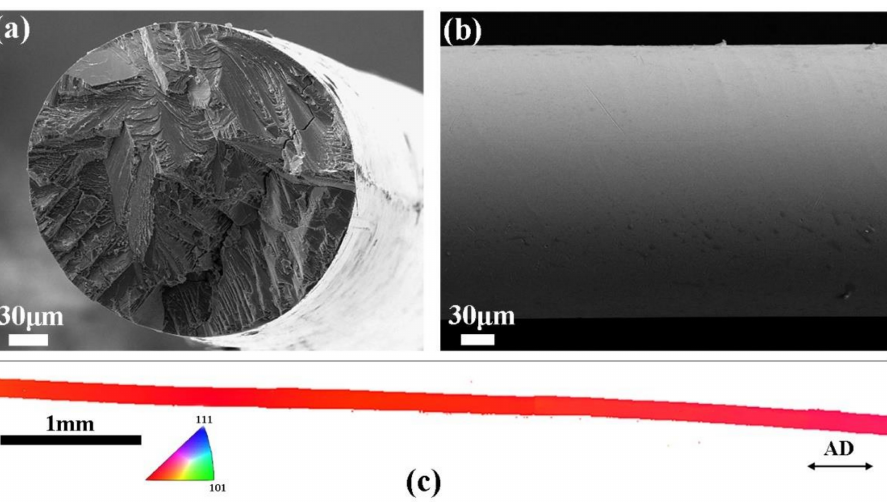
Figure 1. Microstructure of the Ni 50 Mn 34 Fe 3 In 13 microwire at room temperature. ( a , b ) SEM images of the cross-section ( a ) surface ( b ); ( c ) Electron backscatter diffraction (EBSD) orientation map presented in inverse pole figure mode; the legend of a stereographic triangle (parallel to the wire axis direction AD) is also